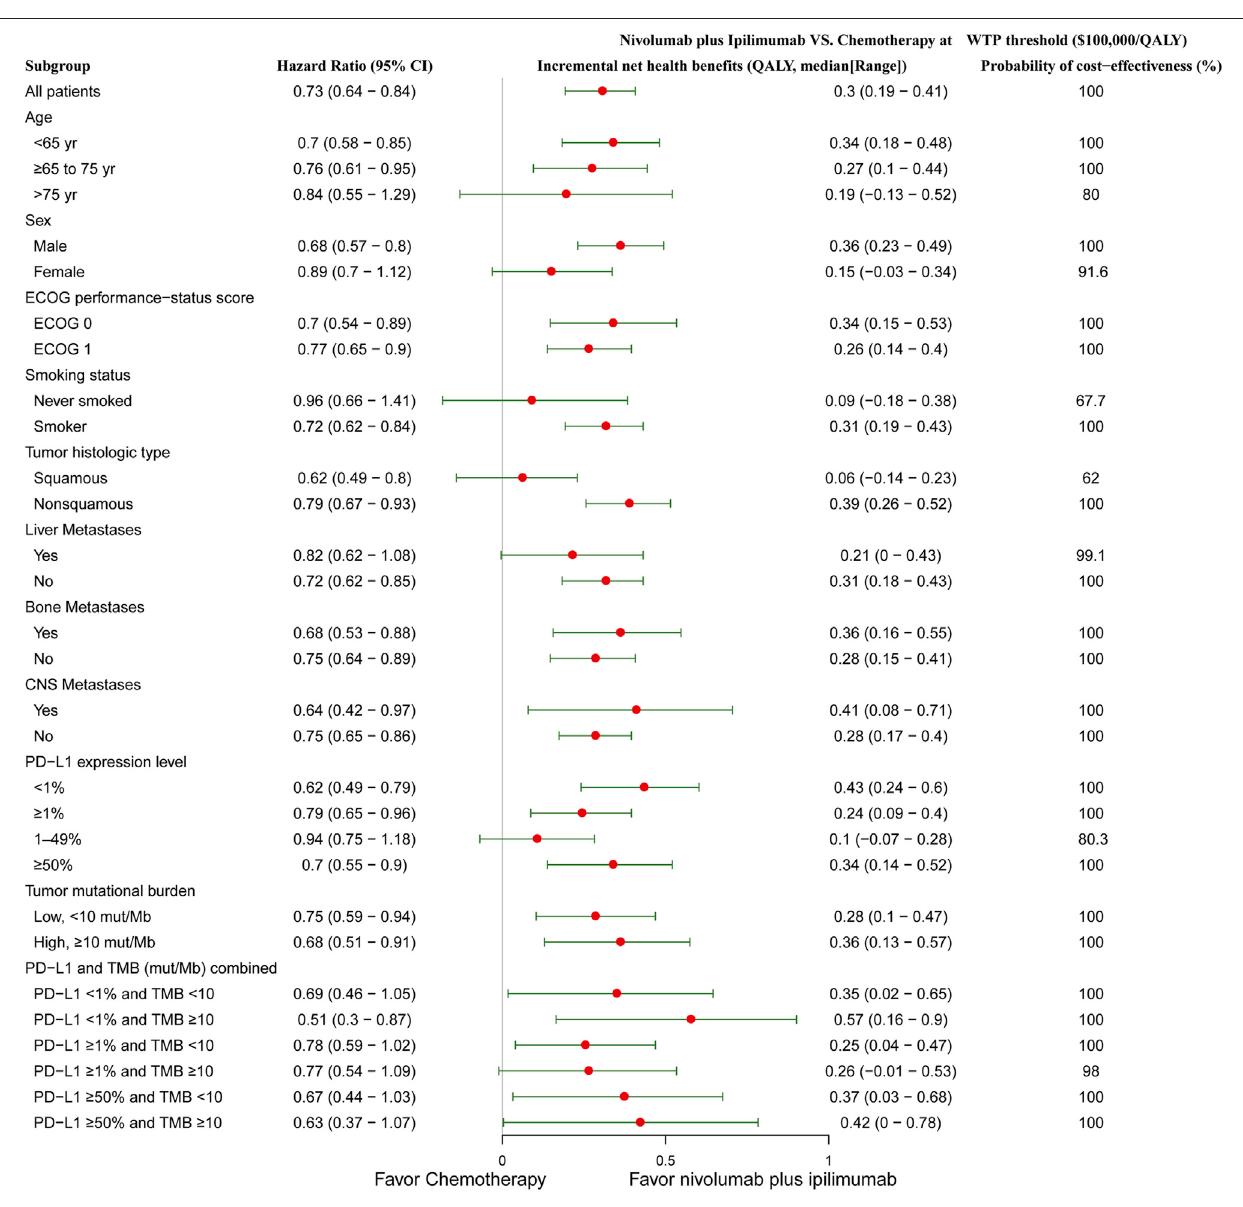
FIGURE 2 | Subgroup analysis of incremental net health bene fi ts (INHB) and probabilities of cost-effectiveness by varying the hazard ratios (HRs) of OS in the contextoftheUnitedStates.Theverticallineindicatesthepointofnoeffect(INHB (cid:1) 0),theredcircleindicatesthemedianINHB,andthegreenbarindicatestherangesof INHB adjusted by the